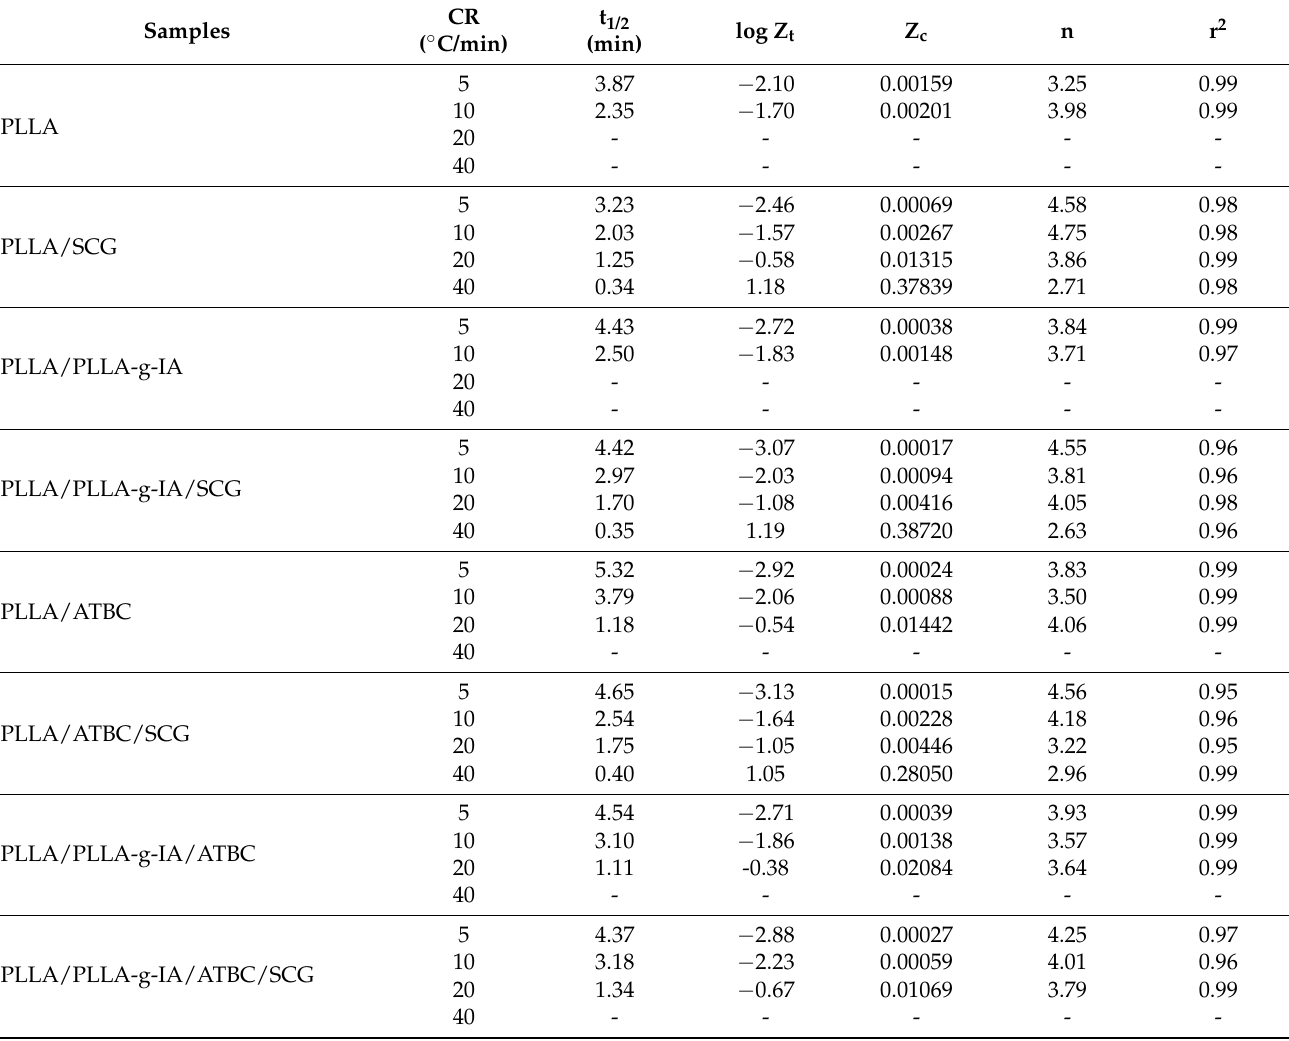
Table 5. The modified Avrami parameters for the non-isothermal crystallization of PLLA, PLLA/PLLA-g-IA, PLLA/ATBC, and PLLA/PLLA-g-IA/ATBC